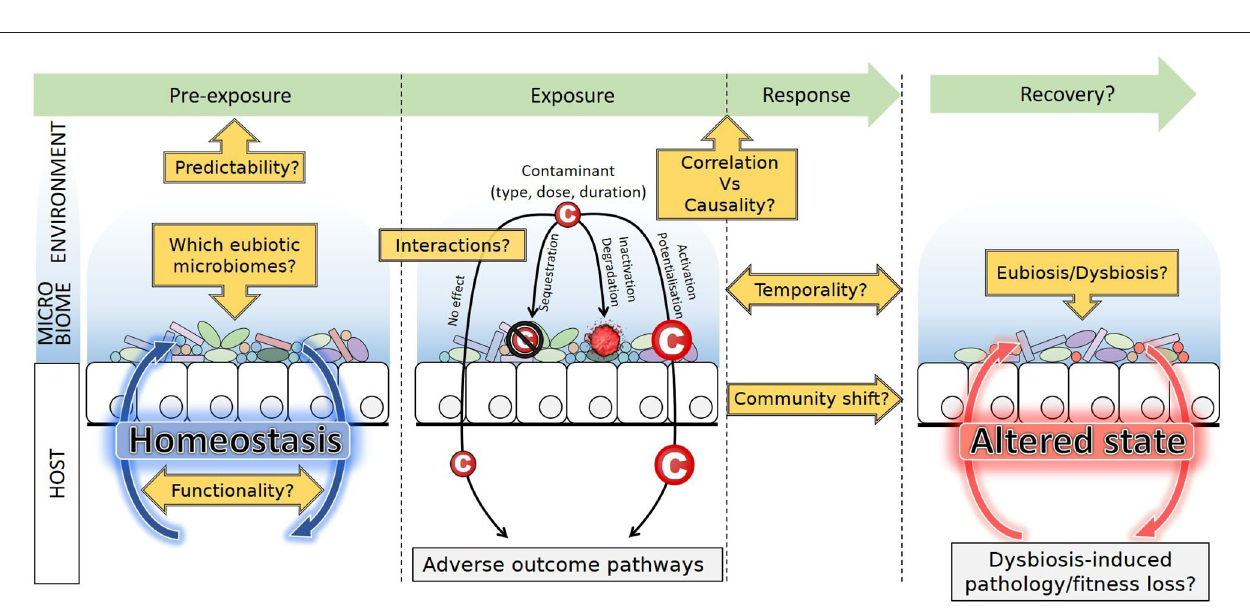
FIGURE 2 | Sitting at the interface between environment and host, the microbiome may interact with contaminants. Sequestration, inactivation, and degradation mitigate potential effects on host health, while activation or potentialization reinforce the effect of contaminants. Microbiome composition, abundance and functions respond to exposure, and dysbiosis can occur. Post-exposure recovery leads to a new stable state, identical, or altered compared to the pre-exposure state. Future lines of research are emphasized. Although contaminants may alter the host health through adverse outcome pathways, dysbiosis itself may also induce pathology and fitness loss, difficult to disentangle from each